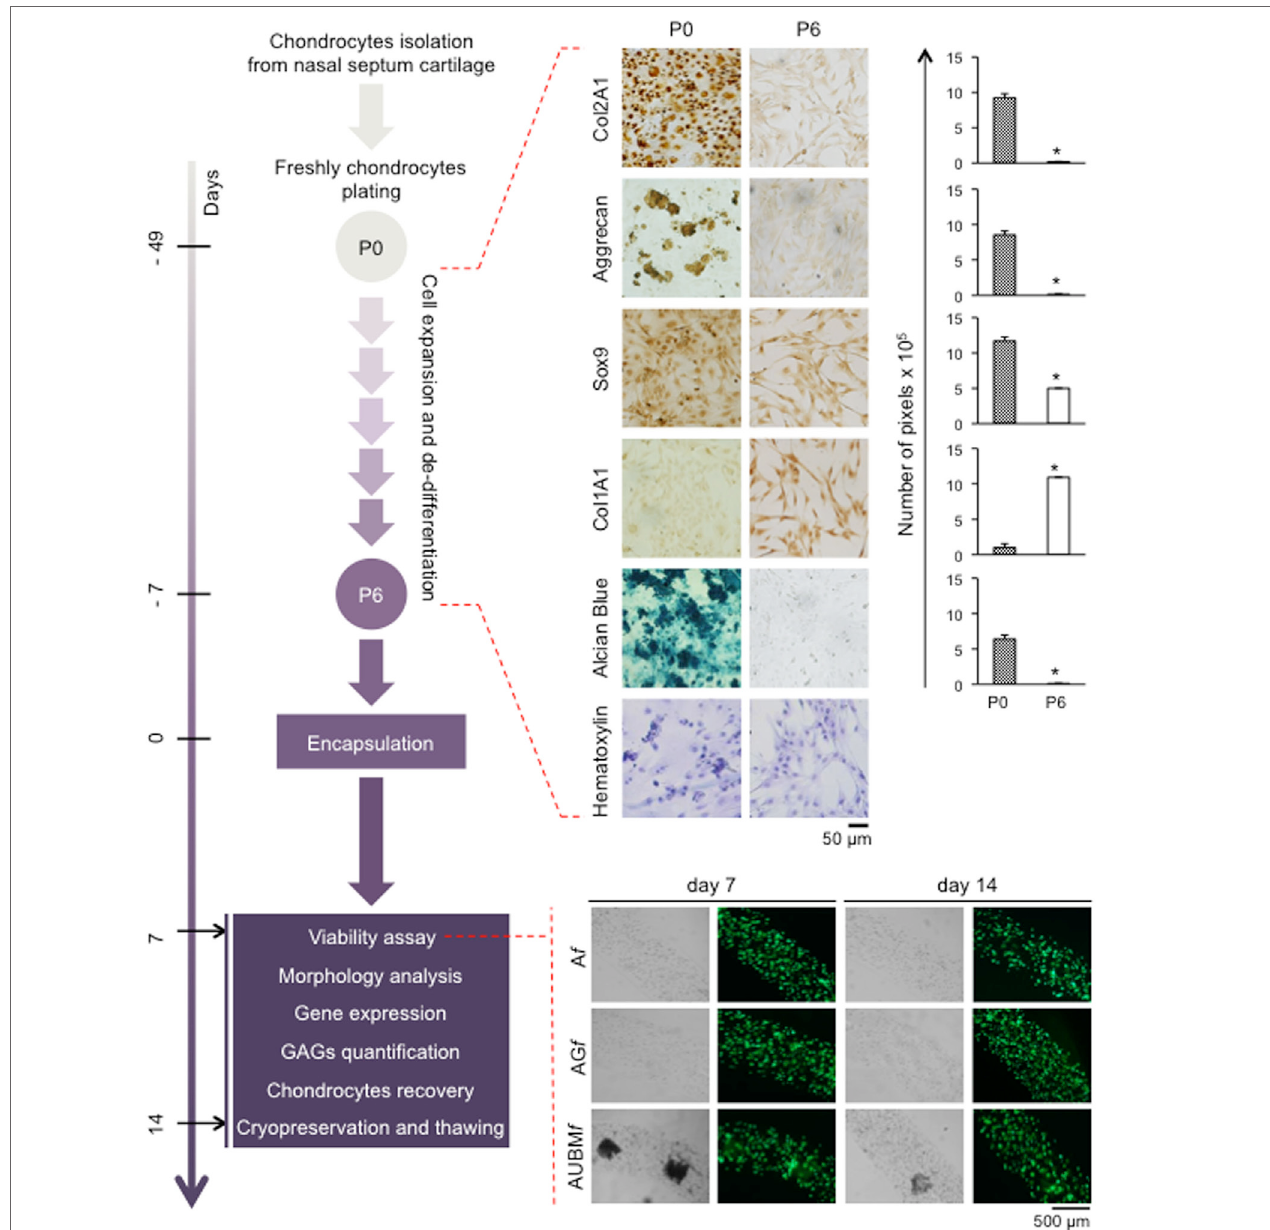
FigUre 3 | Schematic representation of the experimental approach. Human chondrocytes were isolated from nasal septum biopsy, expanded, and dedifferentiated up to the sixth culture passage (P6). Cells were then embedded in A f , AG f , and AUBM f and subjected to the indicated analysis at days 7 and 14. Dedifferentiation process from passage 0 (P0) to passage 6 (P6) has been monitored: protein expression of cartilage-related genes (Col2A1, Aggrecan, and Sox9), and Col1A1 was investigated by immunocytochemical analysis. Alcian Blue staining for sulfate glycosaminoglycans (GAGs) detection is also reported. Cell morphology was evaluated by hematoxylin staining. Representative optical photomicrographs are reported. Pictures of at least four random fields of three replicates were captured for densitometric analysis using ImageJ software. Data are presented as means of pixels per 100 cells ± SEM (* p ≤ 0.05). Cell viability of embedded cells has also been investigated, and optical and fluorescence photomicrographs after double staining with Calcein-AM/propidium iodide at days 7 and 14 of culture in basal medium are reported. The green fluorescence indicates the presence of calcein-labeled live cells, while propidium iodide-labeled dead cells are revealed by red fluorescence. Merged photomicrographs are